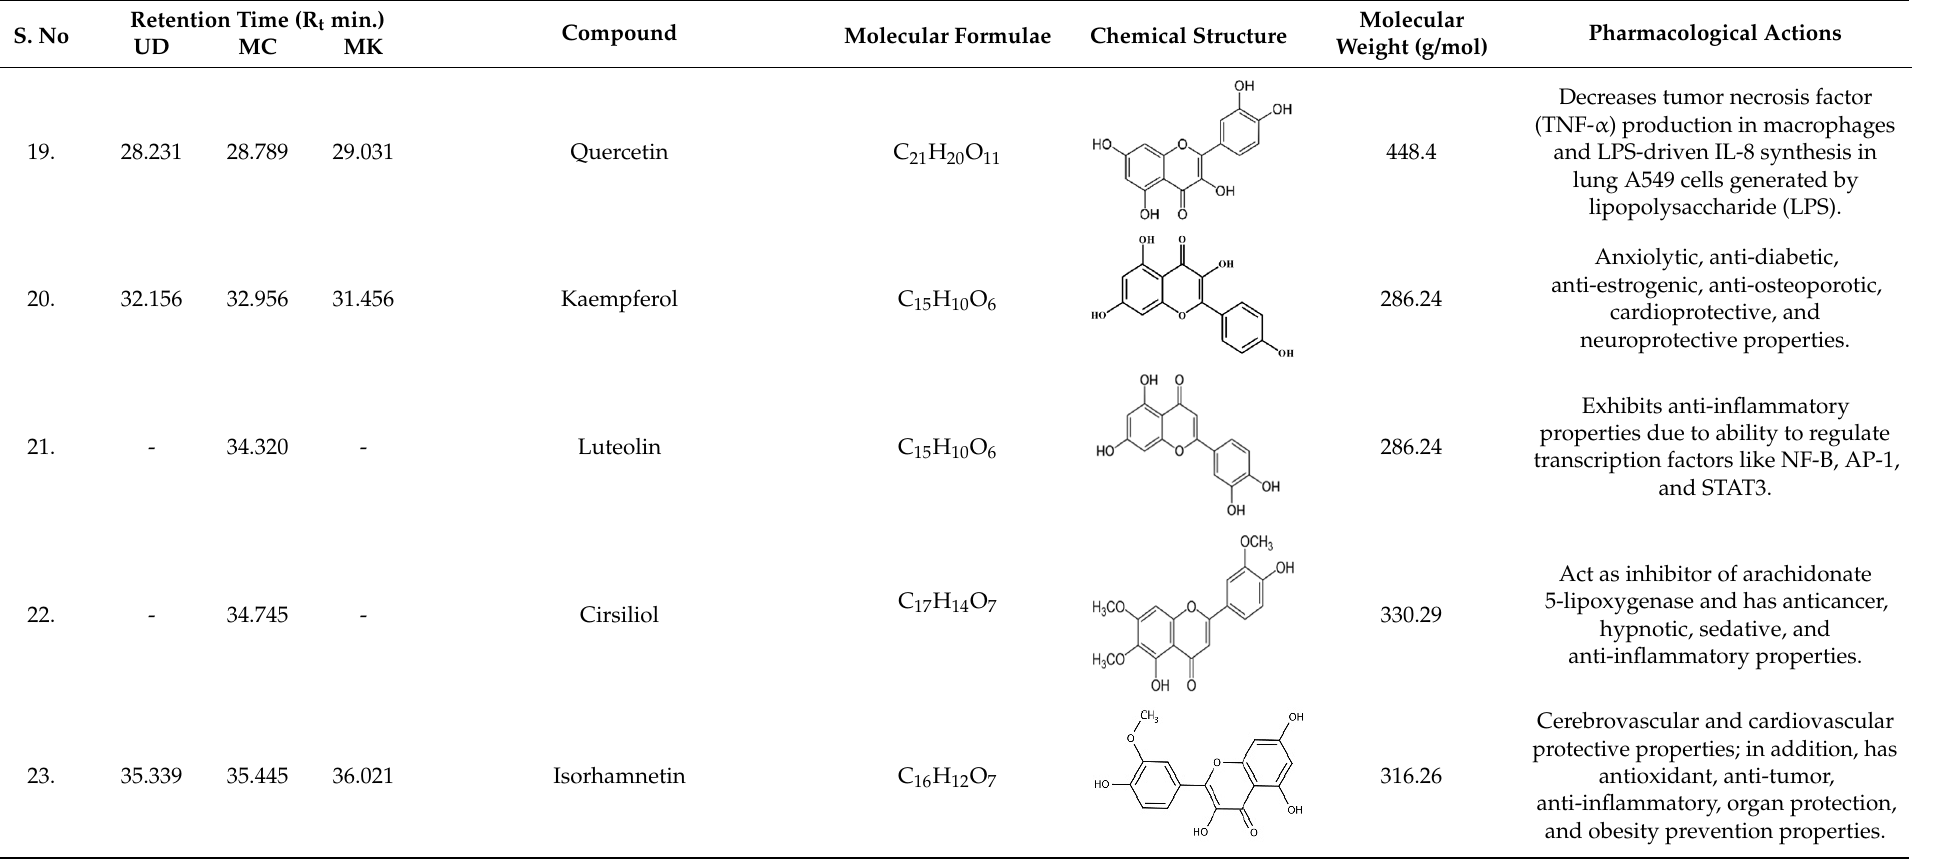
Cerebrovascular and cardiovascular protective properties; in addition, has antioxidant, anti-tumor, anti-inflammatory, organ protection, and obesity prevention